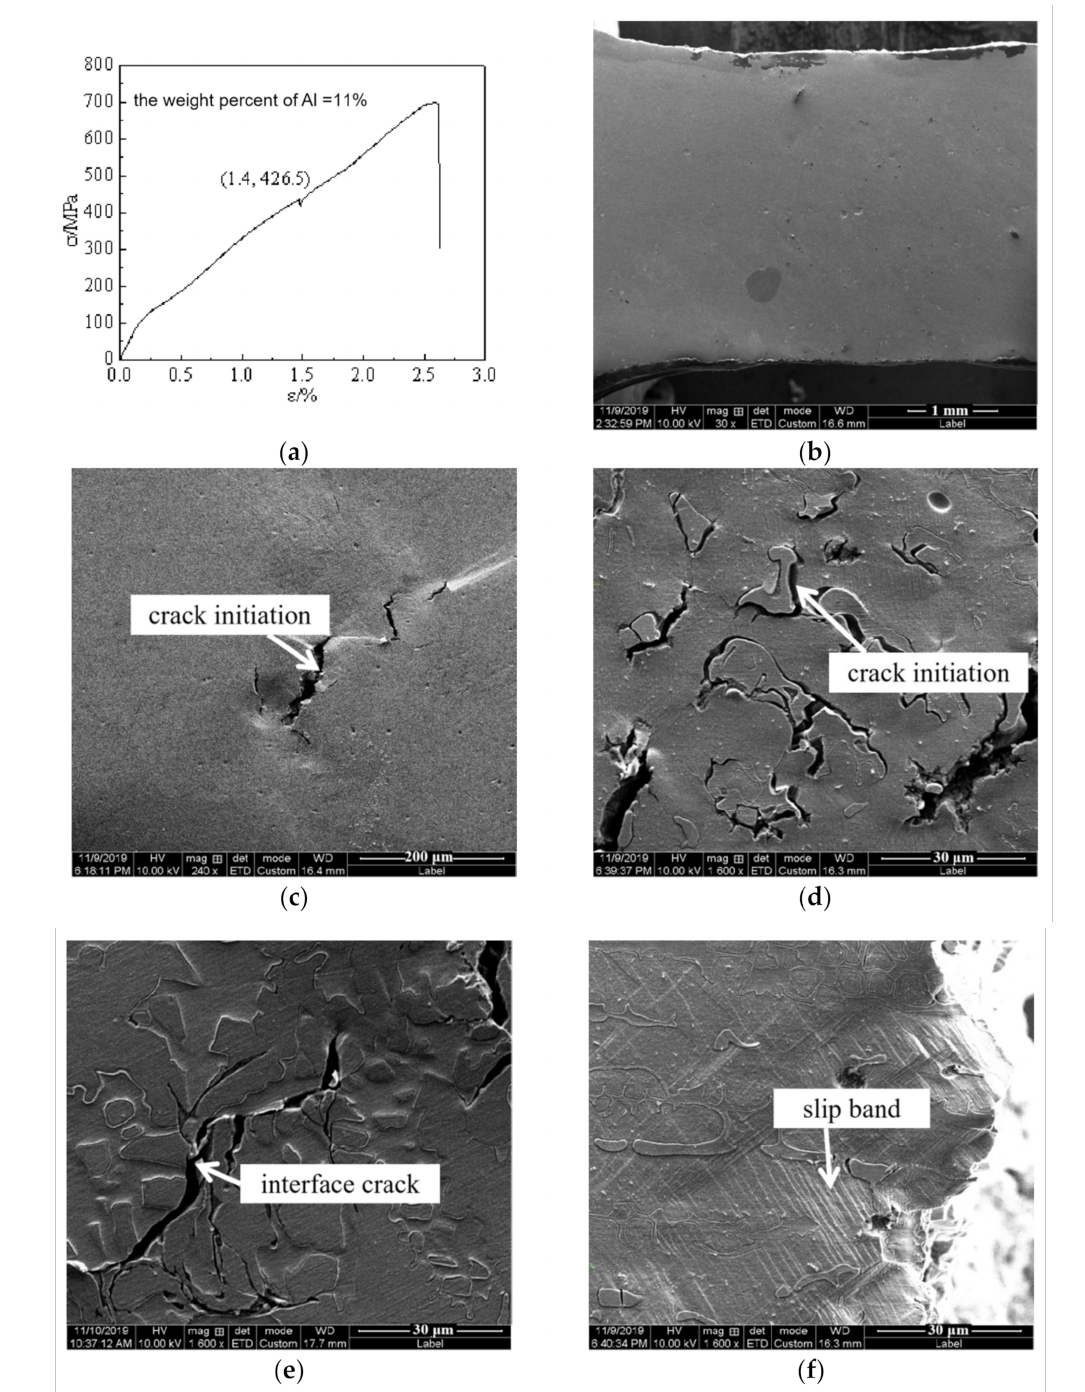
Figure 9. Crack evolution process of Fe-25Mn-11Al-8Ni-C alloy, ( a ) stress–strain curve; ( b ) ε = 0%, σ = 0.0MPa, 30 × ; ( c ) ε = 1.4%, σ = 426.5 MPa, 240 × ; ( d ) ε = 1.4%, σ = 426.5 MPa, 1600 × ; ( e ) ε = 1.4%, σ = 426.5 MPa, 1600 × ; ( f ) ε = 2.6%, σ = 702.5 MPa, 1600 ×